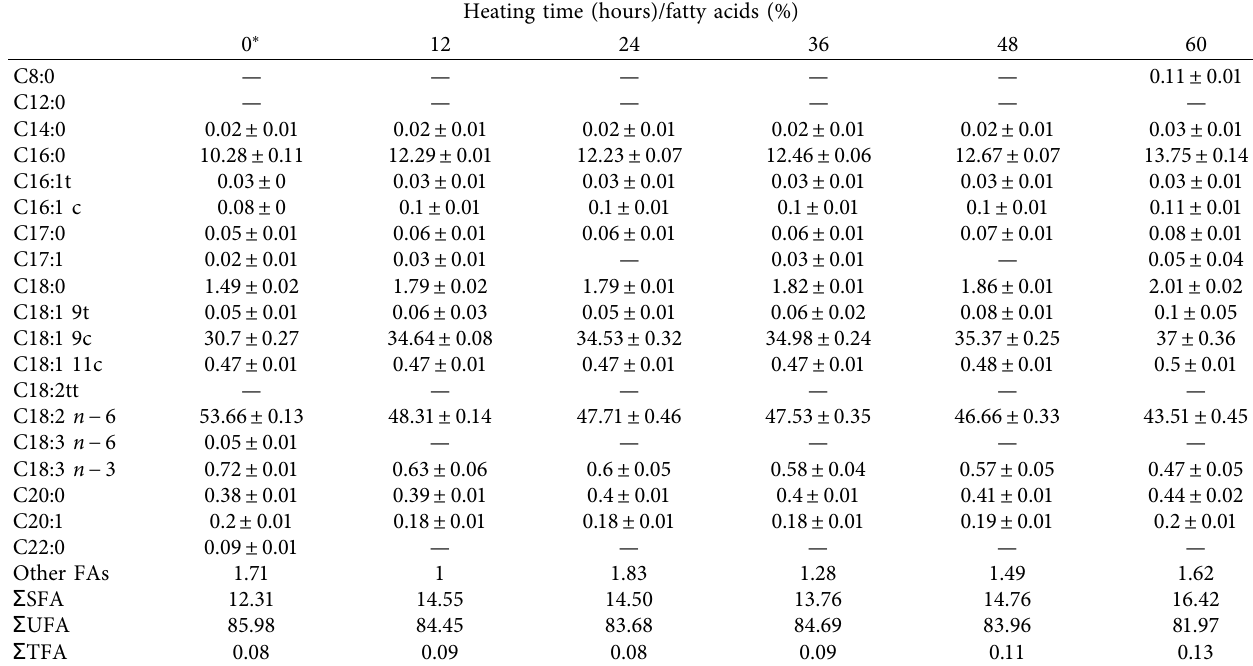
Table 8: Variation of fatty acids of corn oil under 180 ° C heating temperature at different heating times. Heating time (hours)/fatty acids